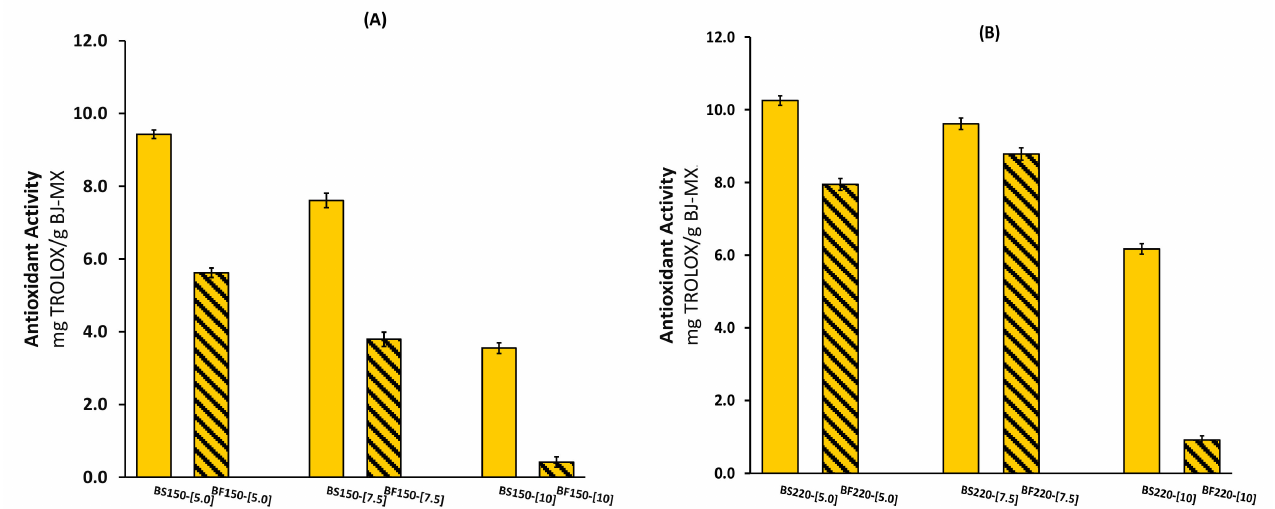
Figure 2. Antioxidant activity of spray-dried BJ-MX powders under different experimental conditions. Inlet temperature of ( A ) 150 ◦ C, and ( B ) 220 ◦